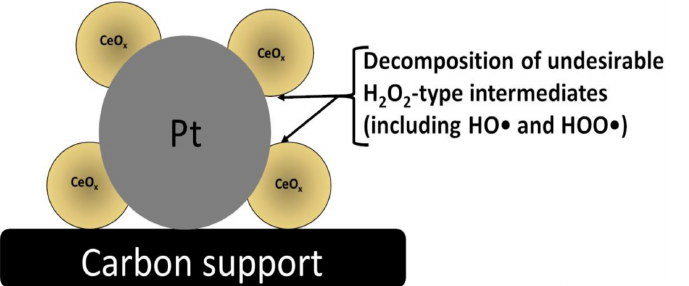
Figure 3. Activity of sub-stoichiometric CeO x nanostructures (with Ce III and Ce IV ionic sites), which are existing on the catalytic platinum surfaces, toward decomposition of undesirable radicals and hydrogen peroxide intermediates [24–27].